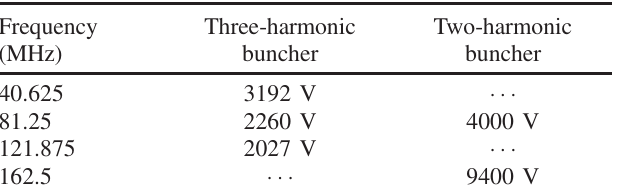
TABLE III. Voltage amplitudes of different harmonics calcu- lated for the U 35 þ beam.